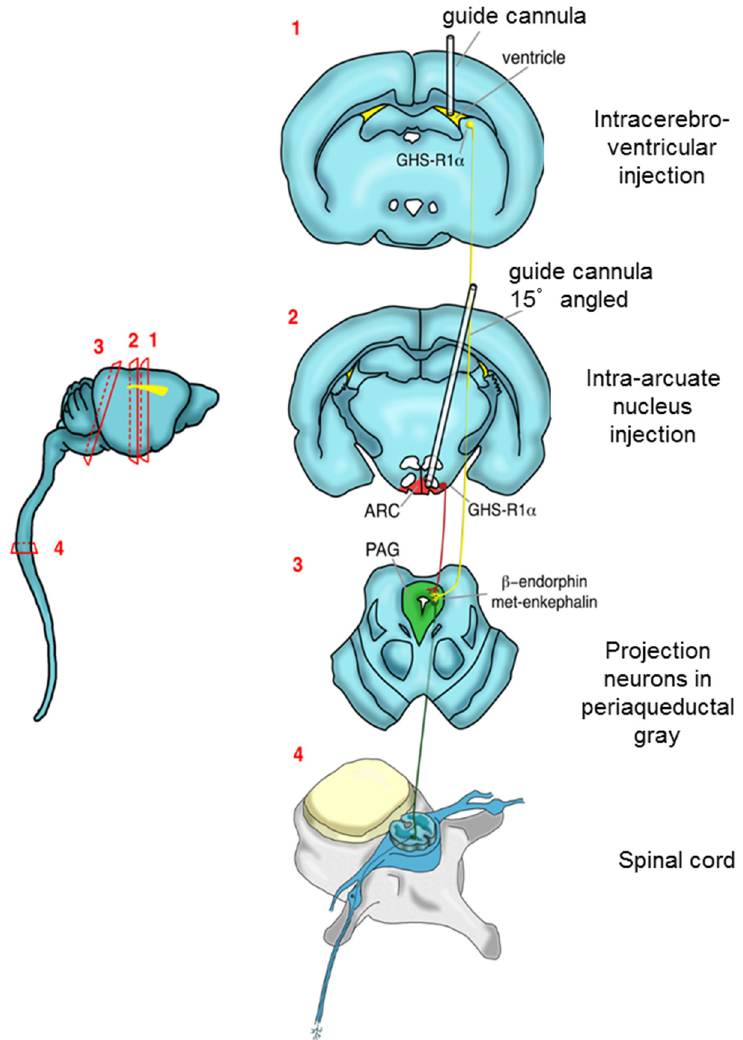
Figure 5. Graphical representation of the neural pathways considered in the study.